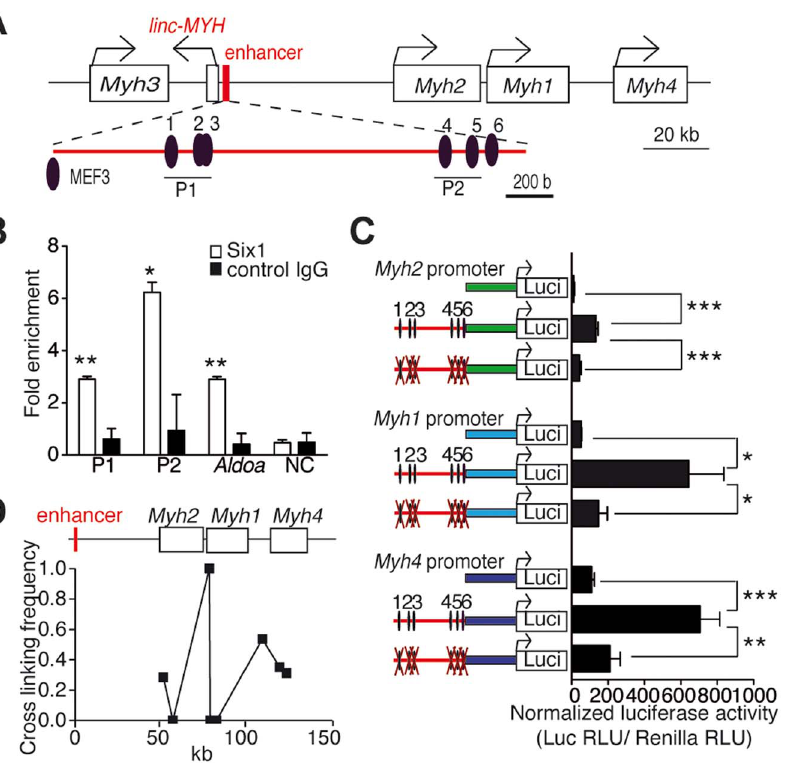
Figure 1. Six1 binds directly the enhancer of the fast Myh gene cluster. (A) Schematic representation of the fast Myh gene cluster. (B) qPCR values of ChIP experiments performed with Six1 antibodies, or IgG on GP and TA chromatin, showing Six1 binding to P1 and P2 regions of the fast Myh enhancer, to the muscle promoter of AldoA , and to an intergenic region located 86 kb 5 9 upstream of Myh3 (NC) (n=3). (C) Luciferase assays from adult TA muscles electroporated with luciferase vectors (indicated) and a TK-Rennila luciferase vector allowing normalization (n=4). (D) qPCR experiments from 3C assays of wild type EDL muscle, showing the direct interactions of Myh2 , Myh1 and Myh4 promoters with the fast Myh enhancer. *P , 0.05, **P , 0.01, ***P , 0.001.